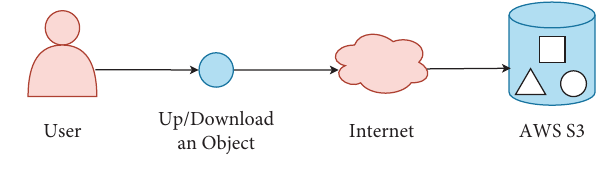
Figure 6: AWS S3